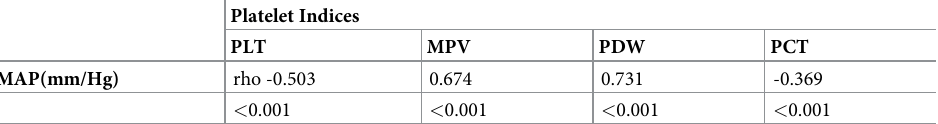
The values of MPV and PDW were significantly elevated with preeclampsia severity. The MAP showed statistically significant positive correlations with PDW and MPV, in contrast, it showed a significant negative correlation with PLT and PCT. At the cut-off value of � 224x10 3/ μ l with a sensitivity of 88.3%, the specificity of 64.2%, PPV of 71.1%, and NPV of 84.5%, PLT differentiate pre-eclamptic women from normotensive with an AUC of 0.858. Whereas the cut-off value � of 8.55fl with a sensitivity of 86.6%, the specificity of 89.2%, PPV of 88.9%, NPV of 86.94% accounted for MPV. The PDW can differentiate normotensive pregnant women from pre-eclamptic women at a cut-off value of � 15.45fl with a sensitivity of 98.3%, the speci- ficity of 91.7%, PPV of 67.42%, and NPV of 96.86%. The PCT at a cut-off value of � 0.1915% with a sensitivity of 83.3%, specificity 52.5%, PPV of 63.68%, and NPV of 75.86% can differen- tiate normotensive pregnant women from pre-eclamptic women.